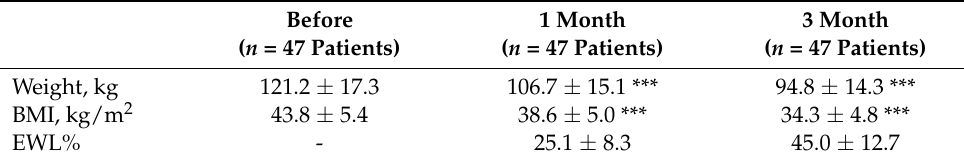
Table 1. Anthropometric characteristics before and at 1 and 3 months after SG.